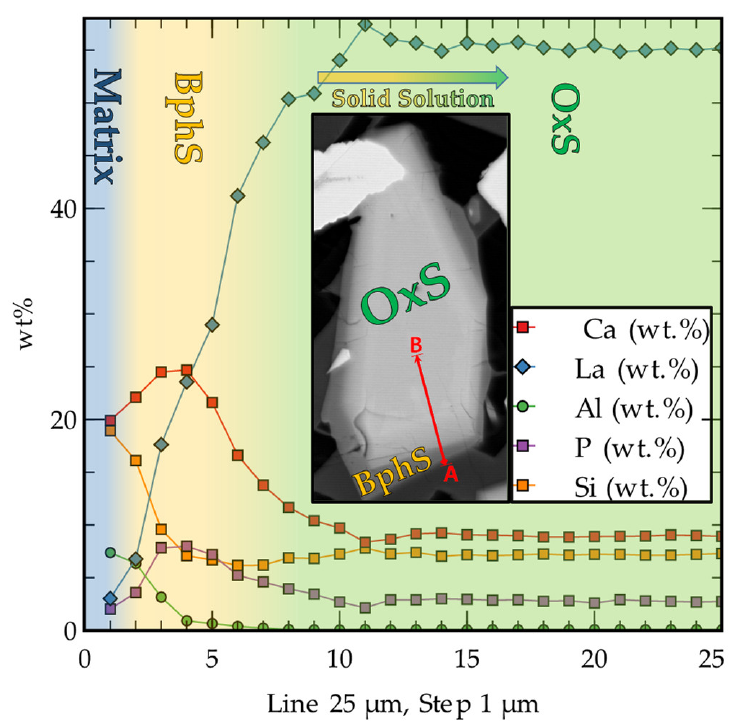
Figure 11. Element distribution profile of a phosphosilicate grain in ASSB-7. Explanations are in the text.